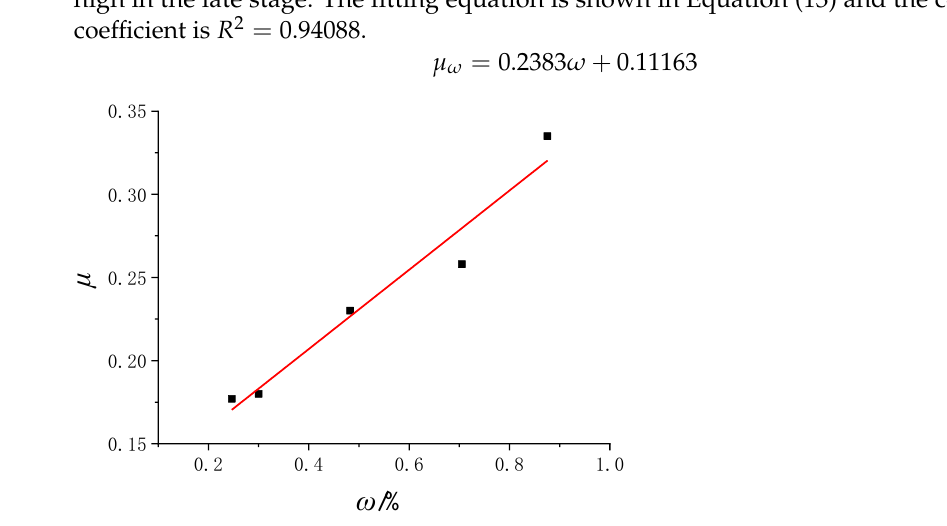
Figure 10. The relationship between the elastic modulus and the rock water content.